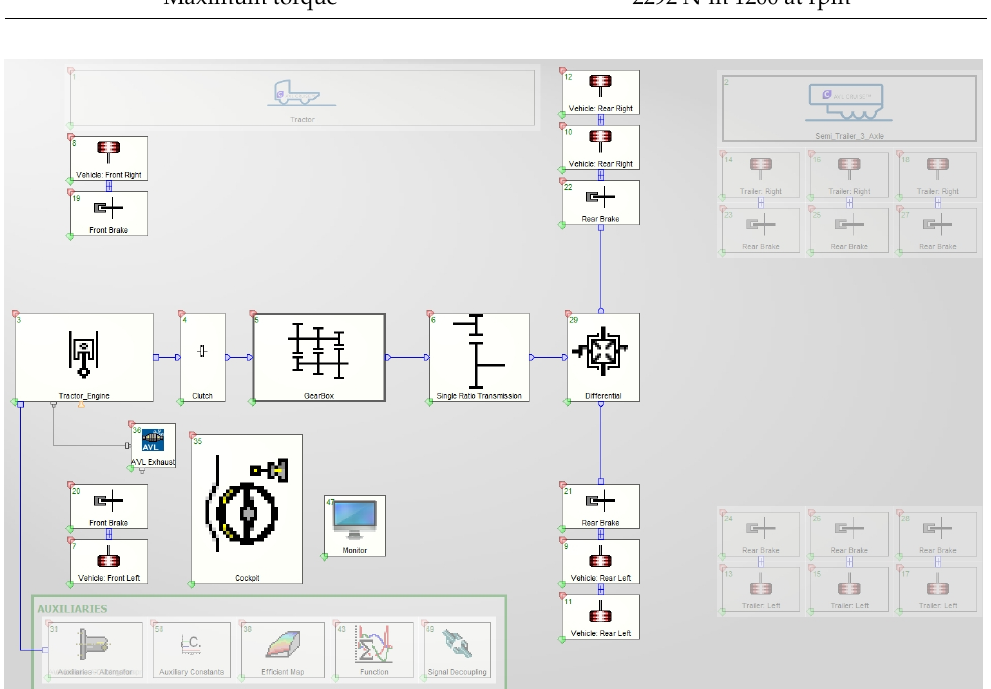
Figure 3. HDV CRUISE